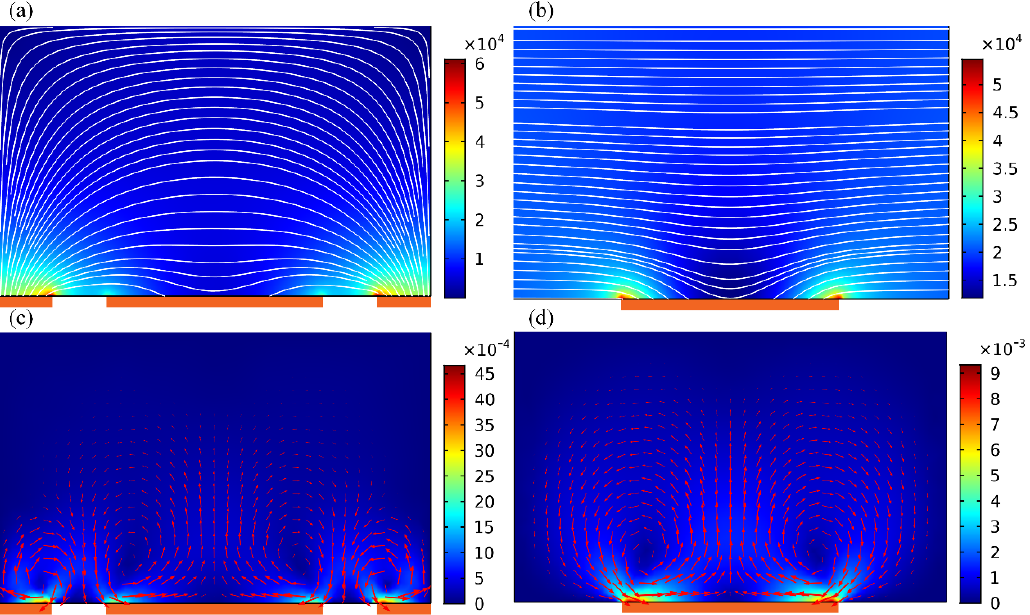
Figure 2. Under identical electric field intensity, a comparison of the basic trait of unbiased ICEO eddies above one central GE in the flow-FET configuration with 2D and 3D driving electrodes at given field frequency f = 200 Hz. For 3D electrode layouts in ( b ) and ( d ), V D = 2 V G = 8 V; while for the 2D counterpart in ( a ) and ( c ), V D = 2 V G = 6 V, such that they share a same magnitude of background electric field of E b = 20,000 V/m. ( a ) A surface and arrow plot of electric field distribution (unit: V/m) in the 2D, and ( b ) 3D electrokinetic micromixer. ( c ) Transversal ICEO fluid motion (unit: m/s) with GE floating in the 2D, and ( d ) 3D device design.